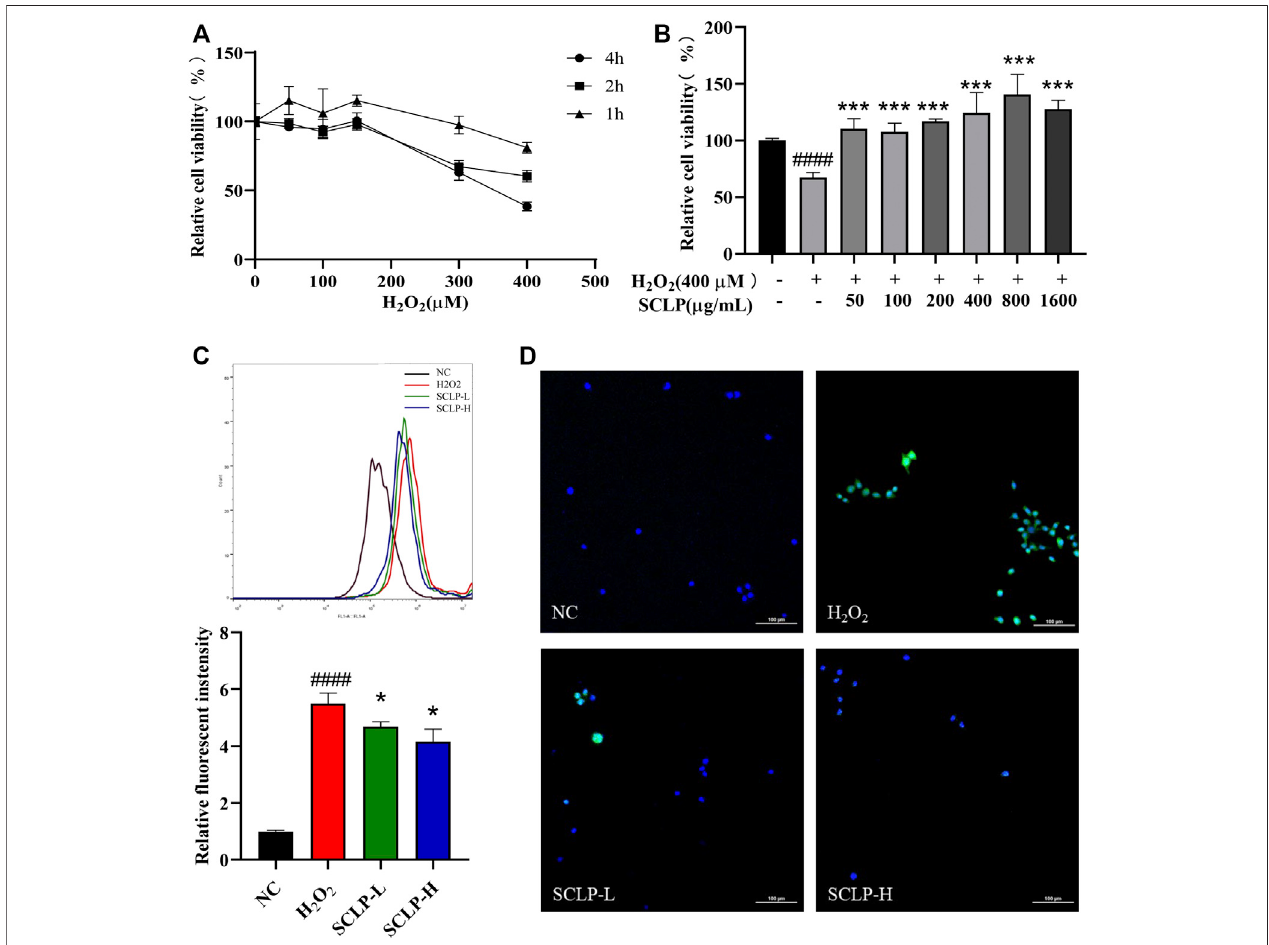
FIGURE 6 | Effect of SCLP on H 2 O 2 -induced oxidative stress in AML12 cells. the effect of different concentrations and incubation time of H 2 O 2 on AML12 cell viability (A) ; the effect of SCLP on the activity of H 2 O 2 -induced AML12 cells (B) ; the effect of SCLP on oxidative stress of AML12 cells induced by H 2 O 2 (ROS and nuclei arelabeledwithDCF(green)andDAPI(blue),respectively.) (C,D) .Dataarepresentedasthemean±S.D.( n =6). #### p < 0.0001vs.NC.* p < 0.05,*** p < 0.001vs.H 2 O 2 . bar: 100 μ